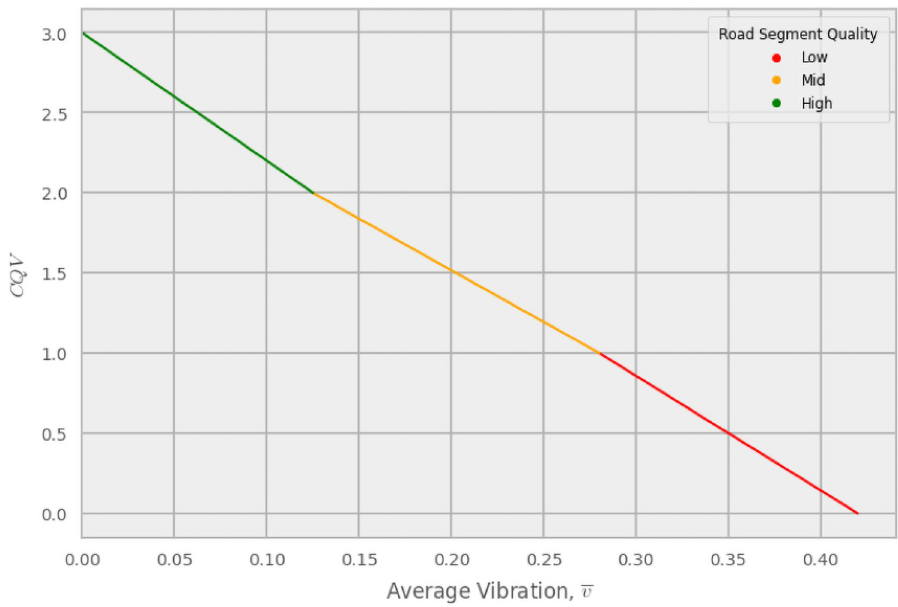
Fig 3. Continuous quality value. Example of the determination of the continuous quality value ( CQV ) of a road segment for a particular device setup. The line is split into 3 parts, representing each of the three quality classes. The slope for the [2–3] quality range is based on the CQV = 2.0 threshold value for the device setup and the constraint of the upper range, CQV = 3.0. The slope for the [1–2] range is determined from the CQV = 1.0 and CQV = 2.0 thresholds. Finally, the slope of the [0–1] range is the average of the combined range [1–3]. Negative CQV s (i.e., roughness values greater than the maximum defined) were re-specified to 0. In this example, the threshold between , is 0.125, and the threshold between mid and low, � v , is 0.28. The colors red, orange, high and mid-quality roads, � v hm ml and green correspond to the regions of low, mid, and high quality roads, respectively.